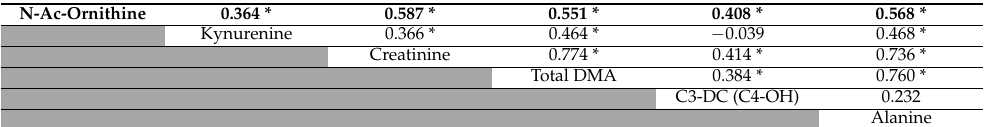
Figure 2. Comparison of the concentration of N-acetylornithine, alanine, hydroxy-butyryl-carnitine, kynurenine, creatinine, and total DMA in the aqueous humor of the two groups. Median in box-and-whisker plots (whiskers indicate the highest and lowest values determined for every molecule in each group, control, or diabetes). * p -value < 0.001. Table 2. Statistical correlations between the data from metabolites selected in the volcano plot. The Pearson coefficient is shown for pair-wise correlations. A total correlation would be defined by coefficient = 1. * False Discovery Rate (FDR)-corrected <